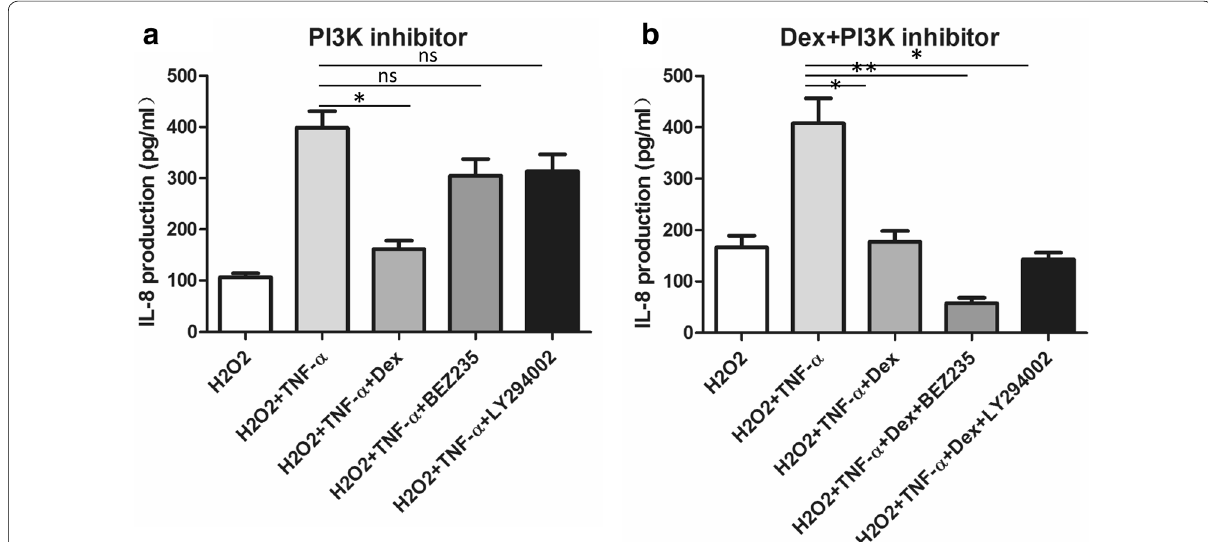
Fig. 5 The effect of the PI3K inhibitor alone and in combination with dexamethasone on IL-8 release in the H 2 O 2 -TNFα-U937 cell model. a The IL-8 concentration was upon the addition of dexamethasone, BEZ235, and LY294002 was measured by ELISA. b The IL-8 concentration upon the